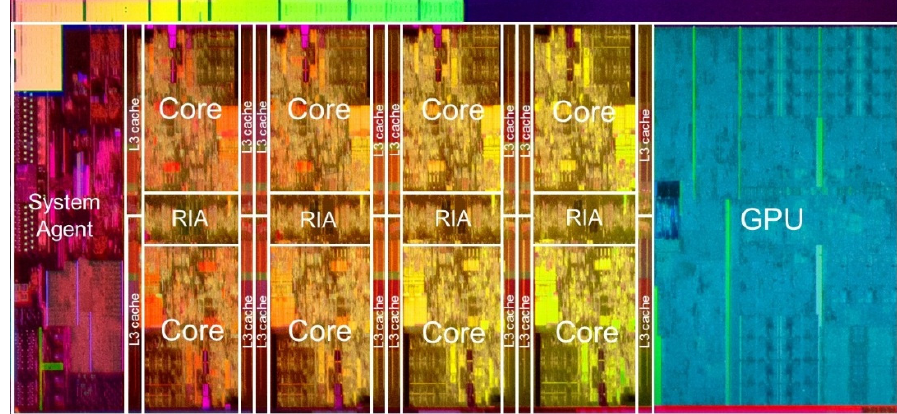
Figure 3. The original floorplan of an Intel i9-9900K processor (source: Intel). GPU – graphics processing unit, RIA – ring interconnection agent. The total die area is about 178 mm 2 .